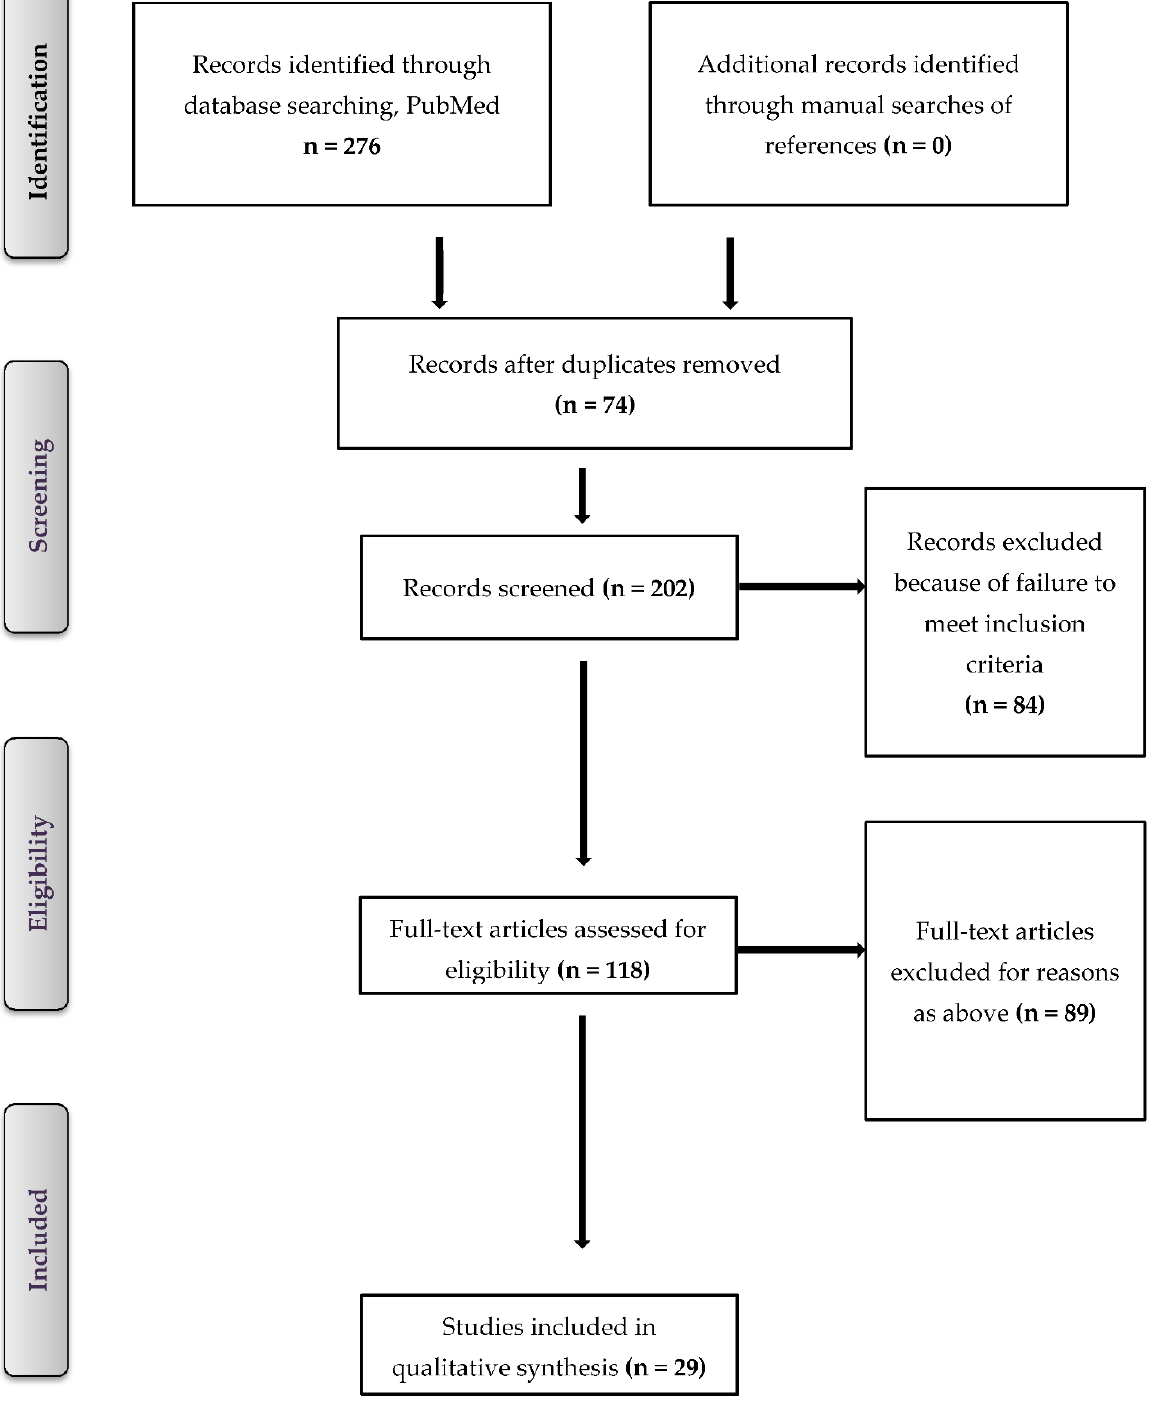
Figure 1. Flow chart presenting the methodology used to obtain the selected articles. Table 1. Demographic and clinical characteristics of 86 cases of Fusarium onychomycosis.